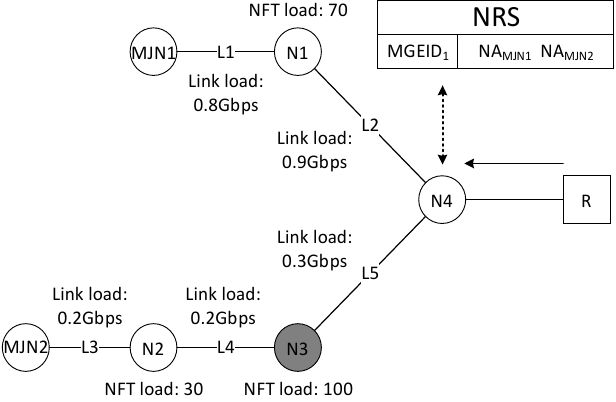
Figure 4. The example of the MJN selection process in AHHM.